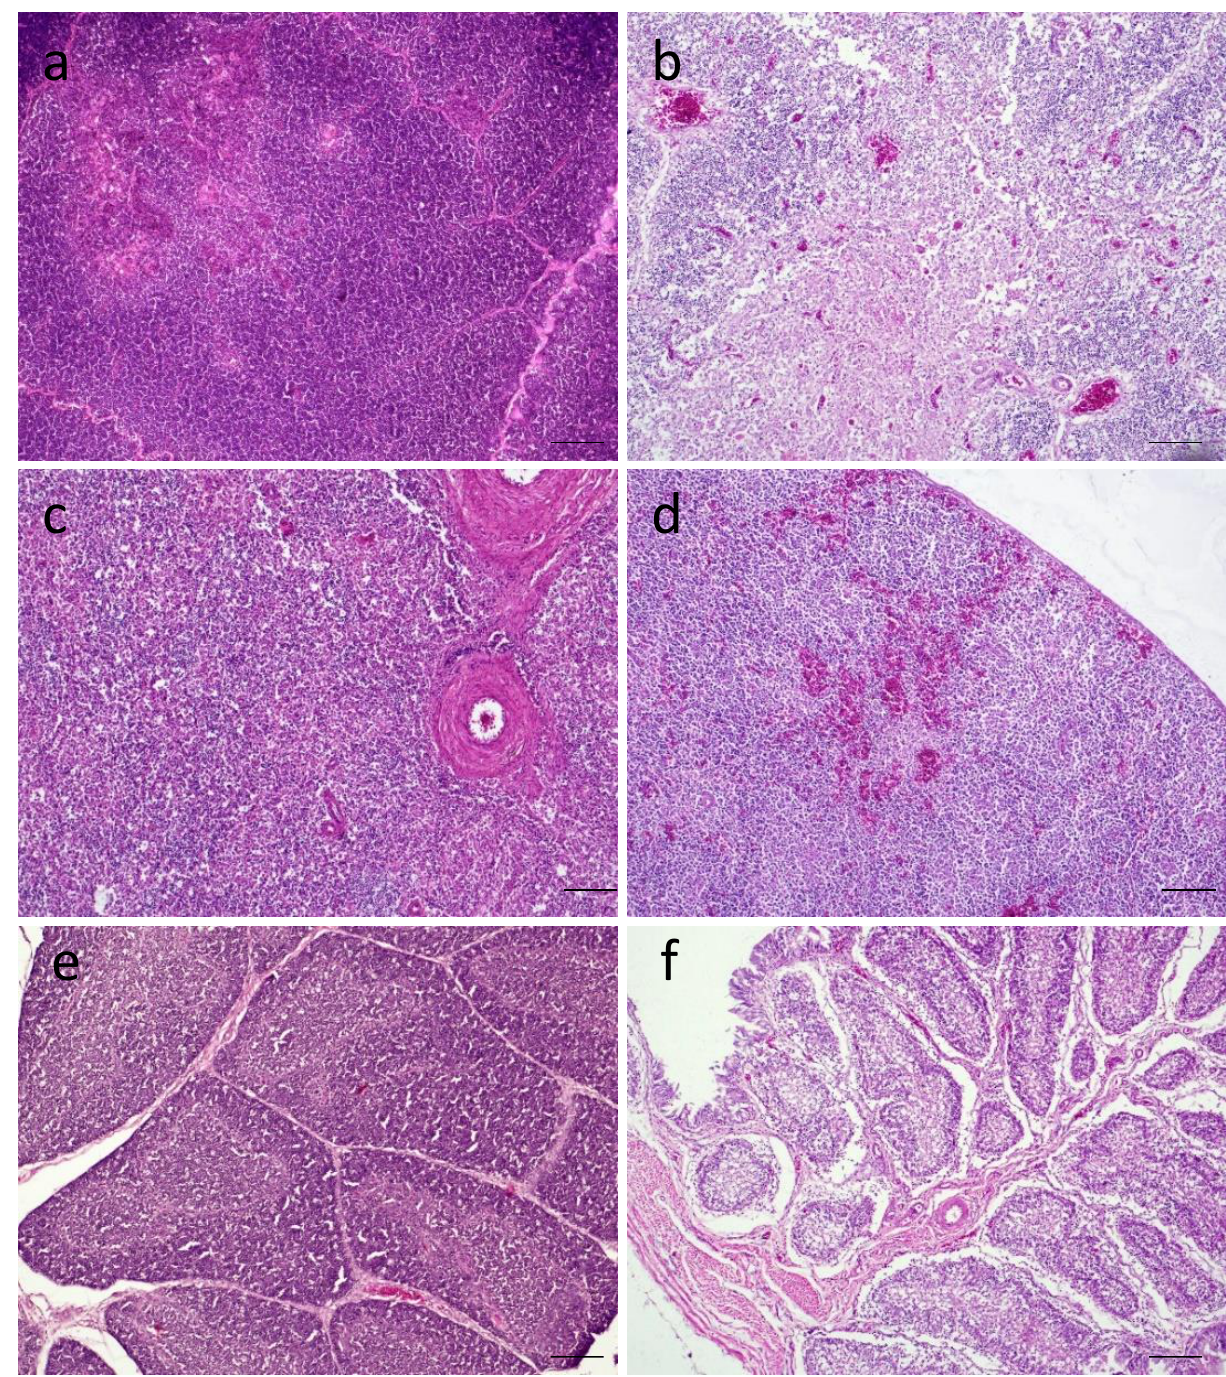
Figure 6. Histopathological changes in tissues of LT67-inoculated chickens. ( a ) Section of thymus of control chickens showing normal histology, ( b ) section of thymus of inoculated chickens showing congestion and multifocal lymphoid depletion, ( c ) section of spleen of control chickens showing normal histology, ( d ) section of spleen of inoculated chickens showing congestion in the parenchym € a, ( e ) section of bursa of Fabricius of control chickens showing some age-dependent depletion of lymphocytes in the bursal follicles, and ( f ) section of bursa of Fabricius of inoculated chickens showing severe lymphoid depletion leaving empty bursal follicles. H&E stain. Bar (=50 μm) indi- cates magnification.